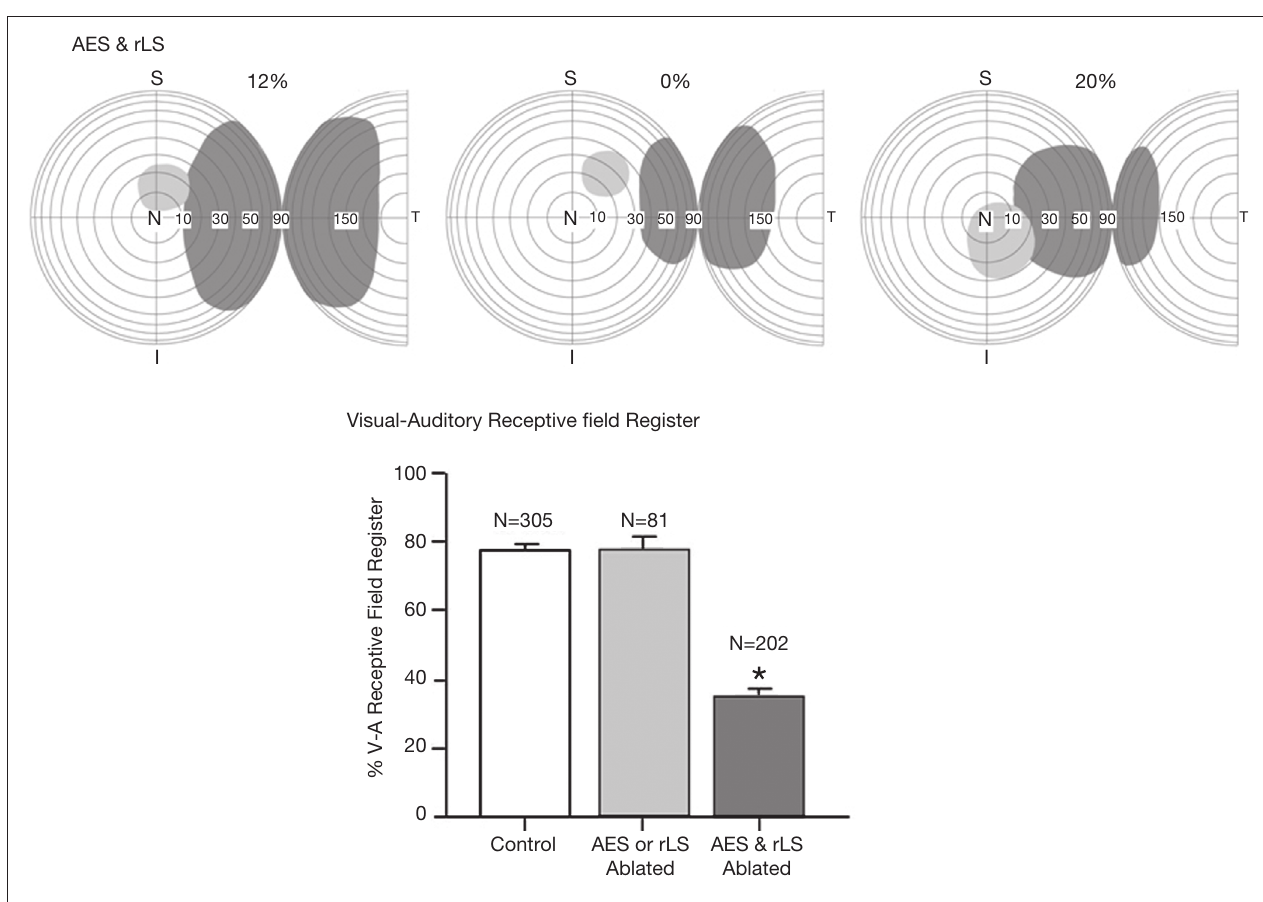
FIGURE 5 | Three characteristic examples of the loss of visual–auditory receptive fi eld overlap following combined lesions of the anterior ectosylvian sulcus (AES) and the rostral lateral suprasylvian (rLS). The bar graphs represent the percentage of visual–auditory receptive fi eld register in SC